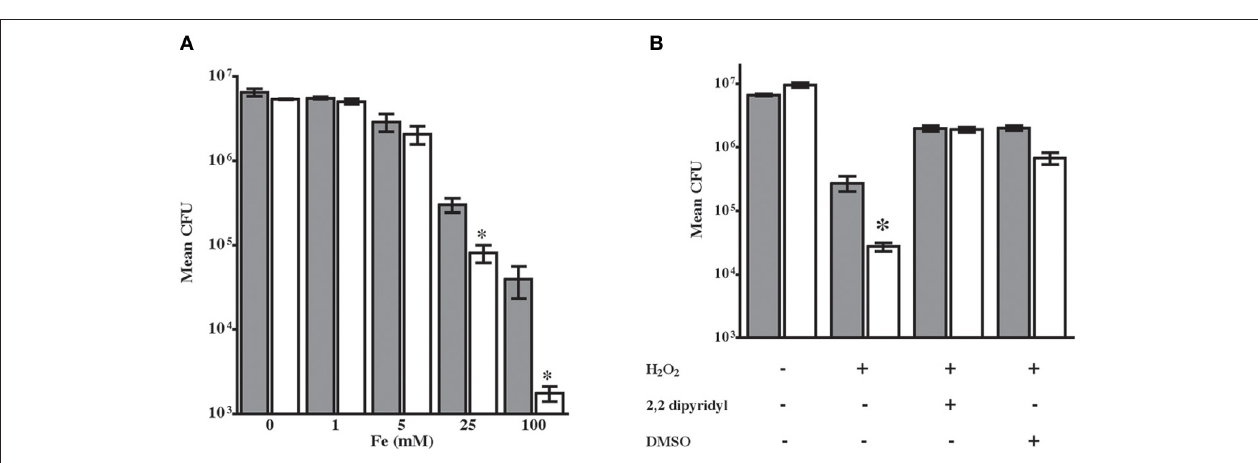
FIGURE 3 | Sensitization of NTHi 86-028NP dps to hydrogen peroxide occurs via iron-mediated hydroxyl radical production. (A) Growth of NTHi 86-028NP (shaded bars) and NTHi 86-028NP dps (white bars) in varying concentrations of iron. Values are means of six independent replicates; statistical significance was determined by analysis of